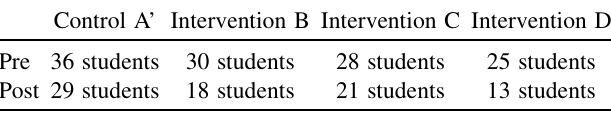
TABLE I. Distribution of students into control and interven- tion